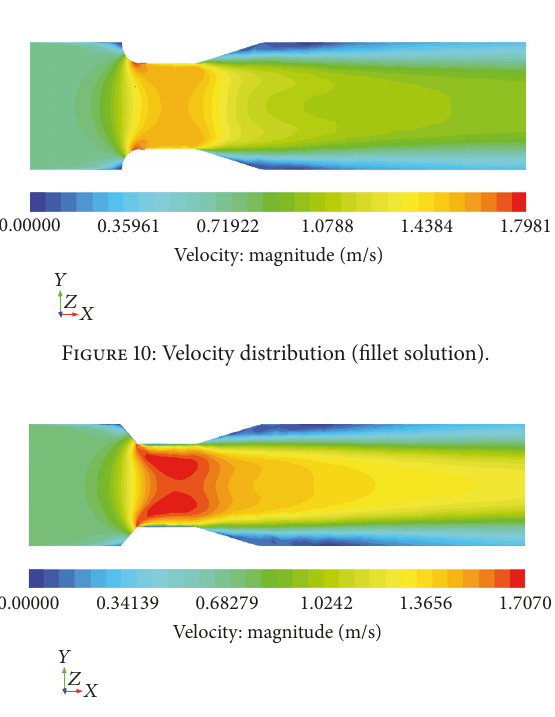
Figure 11: Velocity distribution (chamfer